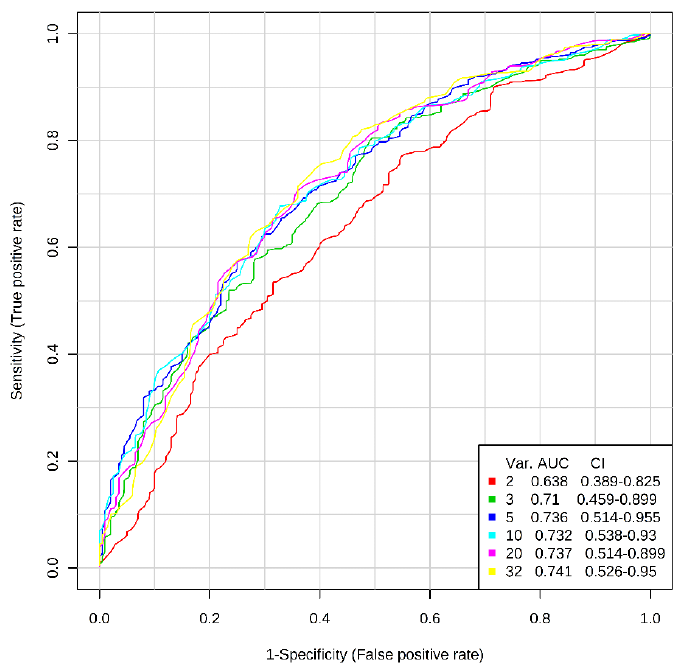
Figure 1. Results of a partial least squares discriminant analysis (PLS-DA) of free amino acid profiles determined in children with asthma and the control group. ( a ): Three-dimensional score plot (with explained variances shown in brackets). ( b ): The variables having the greatest importance in sample classification (amino acids with the highest variable importance in projection (VIP) score). Green and red boxes on the right hand side of the figure show if the levels of the respective amino acids are decreased or increased in the group.